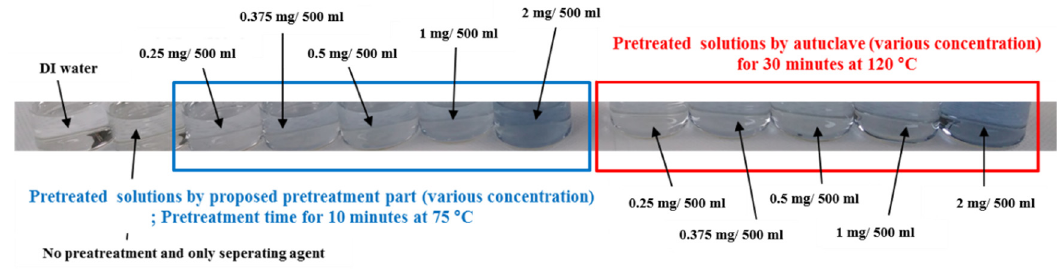
Figure 11. Comparison of the pretreatment performance between the proposed method and the conventional method at different concentrations of phosphorus.